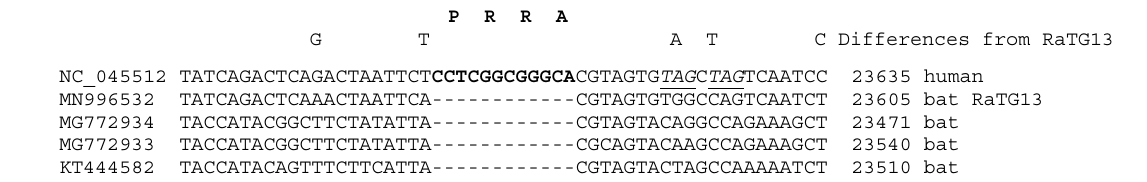
Figure 1. Fragment of the multiple alignments of SARS-CoV-2 S protein RNAs: Sequences surrounding the CCTCG- GCGGGCA insertion in the SARS-CoV-2 sequence (GenBank entry NC_045512.2, the SARS-CoV-2 reference sequence). MN996532.1 is the closest bat homolog RaTG13; MG772934.1, MG772933.1, and KT444582.1 are more distantly related bat homologs. Novel out-of-frame stop codons in the human SARS-CoV-2 are